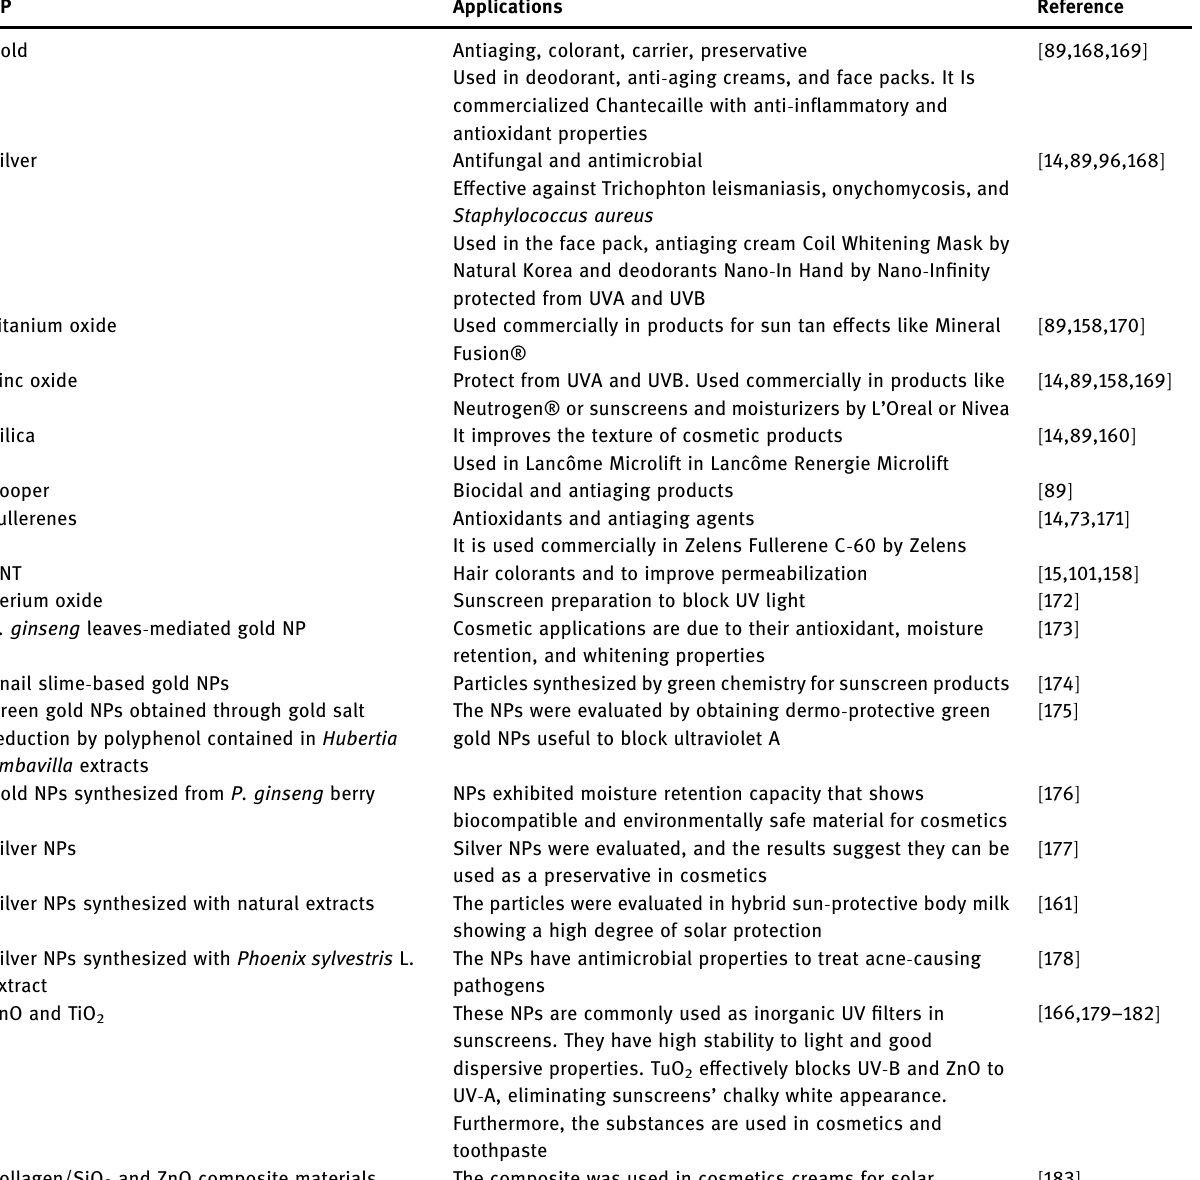
Table 8: Applications of inorganic NPs in the cosmetic industry